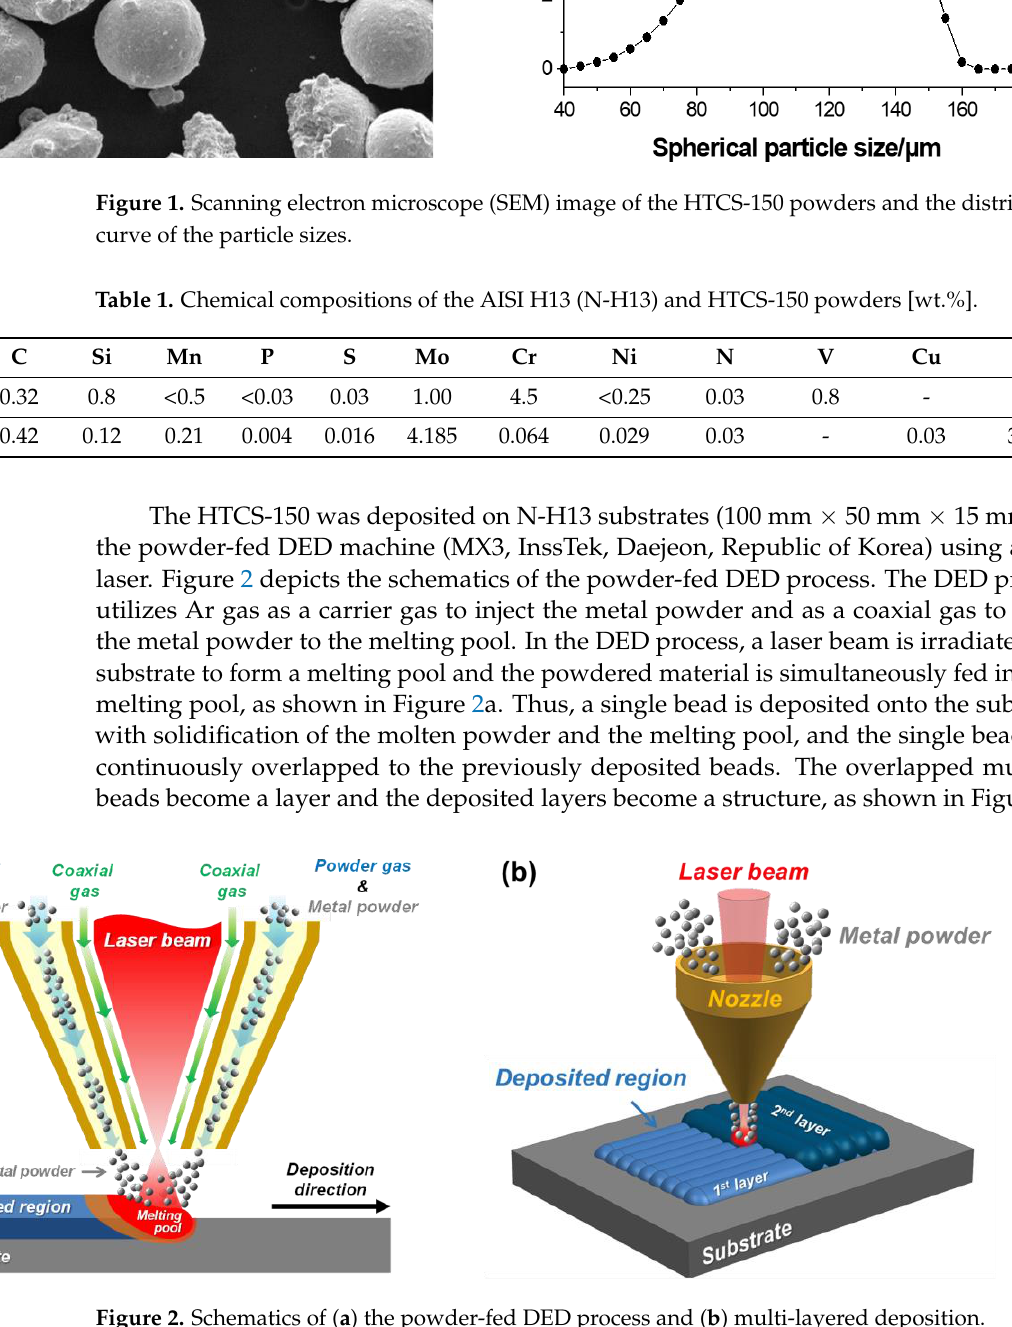
Figure 1. Scanning electron microscope (SEM) image of the HTCS-150 powders and the distribution curve of the particle sizes. Table 1. Chemical compositions of the AISI H13 (N-H13) and HTCS-150 powders [wt.%].